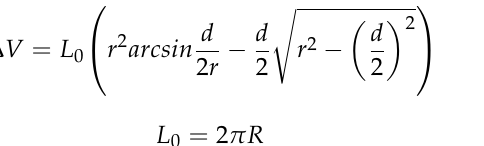
Figure 2. Ball—disc high temperature wear testing machine diagram. ( a ) front view; ( b )top Figure 2. Ball — disc high temperature wear testing machine diagram. ( a ) front view; ( b )top view.